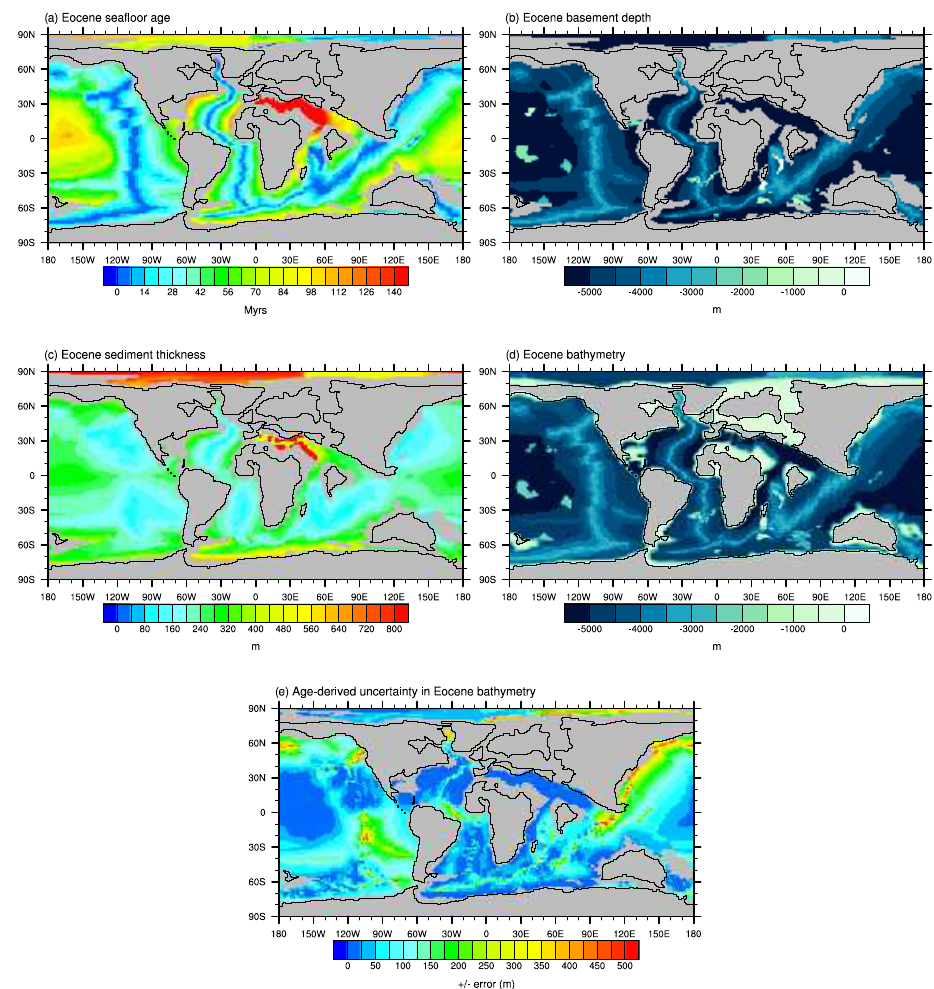
Figure 3. 55Ma (a) seafloor age, (b) basement depth, (c) sediment thickness, (d) final bathymetry and (e) the error margin in our bathymetry based on age uncertainty (values represent the range of uncertainty above and below the bathymetry shown in (d) . Black outlines indicate